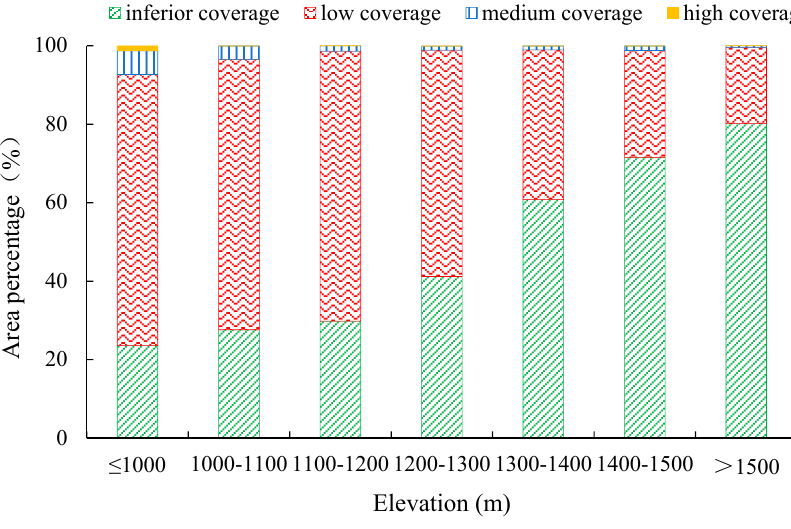
Figure 7. Area percentage of vegetation coverage in different elevations.